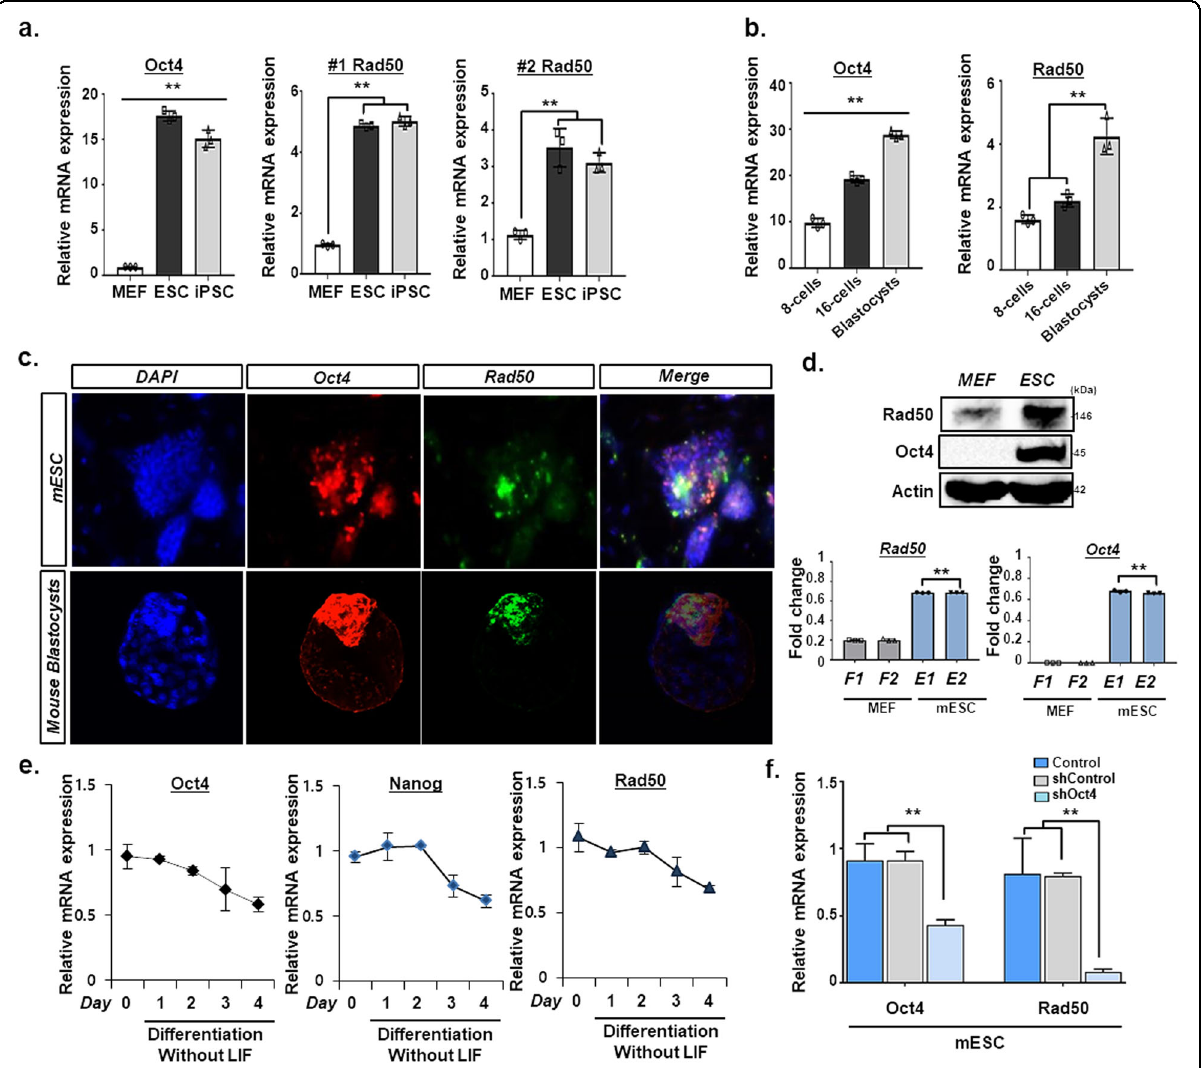
Fig. 1 Expression of Rad50 in pluripotent cells. a Quantitative real-time PCR analysis of Oct4 and Rad50 in MEFs, mESCs, and miPSCs. Data are expressed as the mean ± SEM. ** p < 0.01, ANOVA with Tukey ’ s post hoc test. b Quantitative real-time PCR analysis of Oct4 and Rad50 at the 8-cell stage, 16-cell stage, and E3.5 blastocyst-stage mouse embryos. Data are expressed as the mean ± SEM. ** p < 0.01, ANOVA with Tukey ’ s post hoc test. c Immunohistochemistry for Oct4 (Red), Rad50 (green), and DAPI (blue) in mESCs and blastocyst-stage embryos. d Western blot analysis for Rad50 and Oct4 in MEFs and mESCs. e Quantitative real-time PCR analysis of Oct4, Nanog, and Rad50 expression in mESCs following LIF withdrawal. f Quantitative real-time PCR analysis of Oct4 and Rad50 in mESCs following the addition of siOct4. Data are expressed as the mean ± SEM. ** p < 0.01, ANOVA with Tukey ’ s post hoc test. The images ( c , d ) are representative of ≥ 3 similar